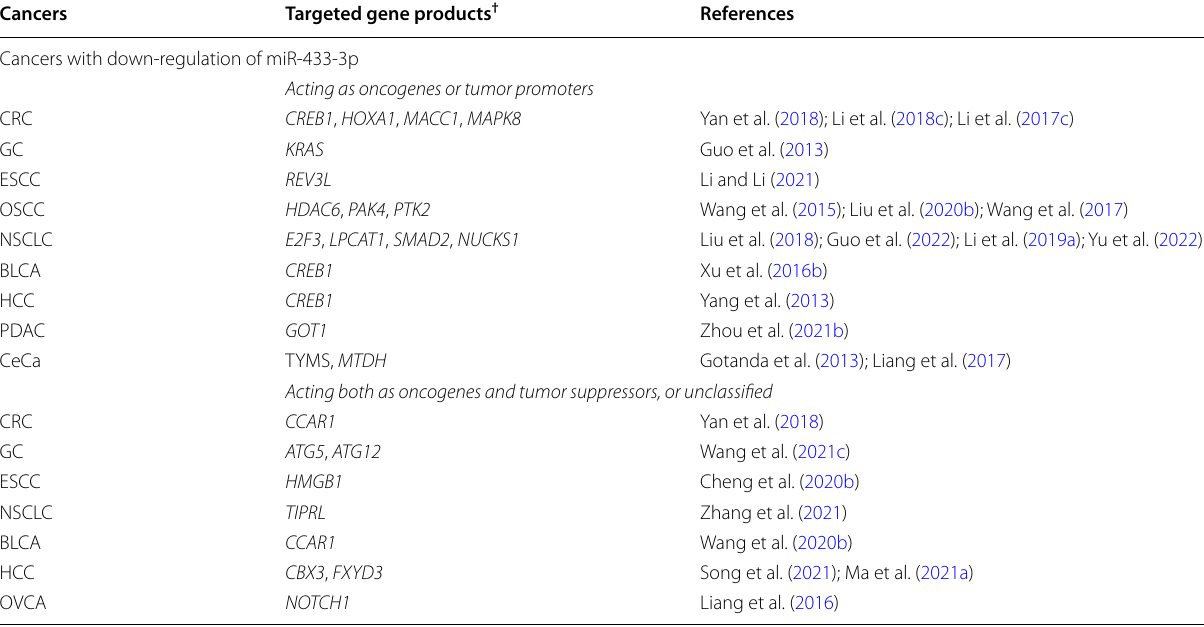
Table 15 Major genes targeted by miR-433-3p in various types of cancer